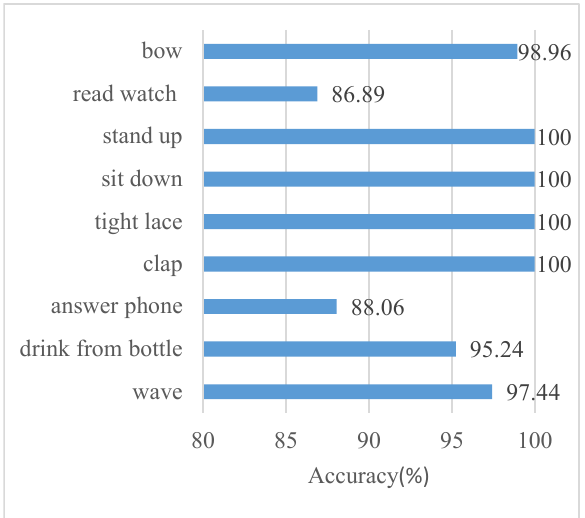
Figure 6. The recognition accuracy of each action on Florence-3D dataset using our method.